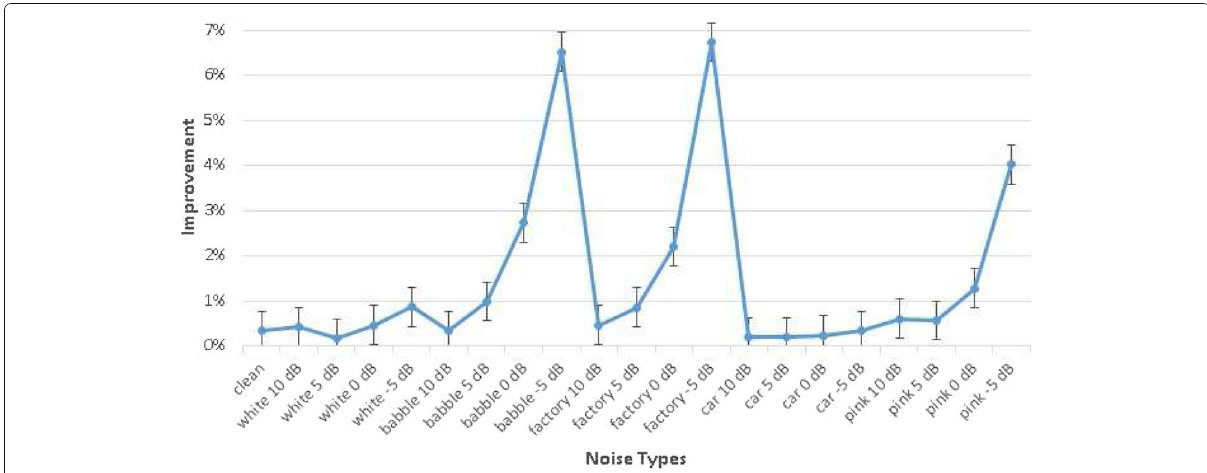
Fig. 8 Improvement of VAD performance